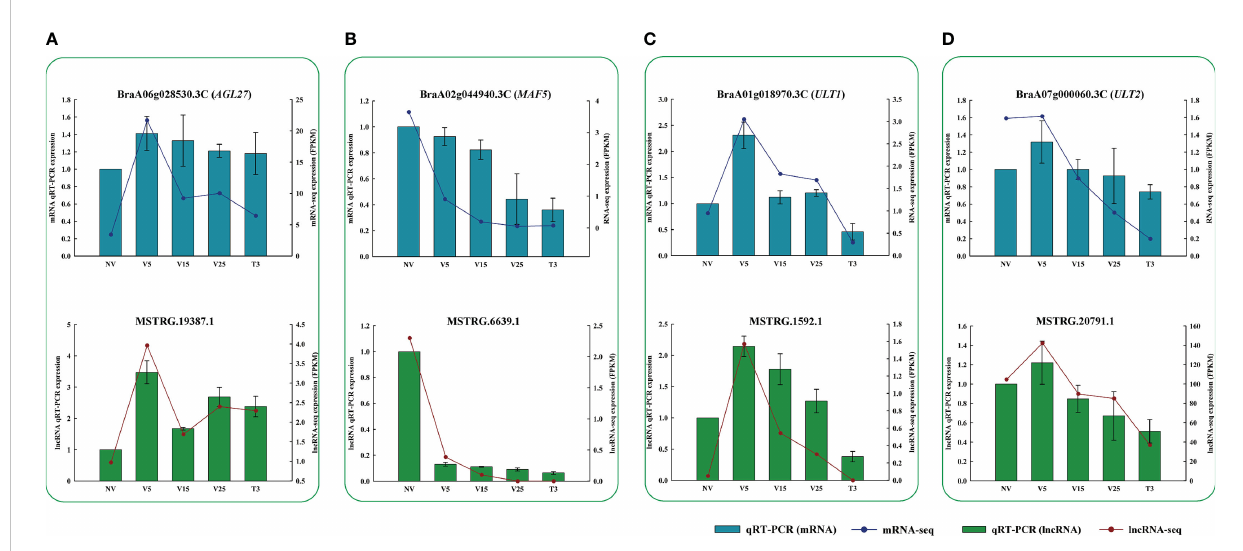
FIGURE 10 Veri fi cation of RNA-seq results via qRT-PCR. Fragment per kilobase of transcript per million mapped reads (FPKM) and relative expression levels of lncRNAs and their regulated mRNAs. (A) lncRNA and the AGL27 gene. (B) lncRNA and the MAF5 gene. (C) lncRNA and the ULT1 gene. (D) lncRNA and the ULT2 gene. Data are presented as the mean ± standard error